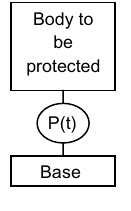
Fig. 1. Conceptual system for limiting isolation capacity